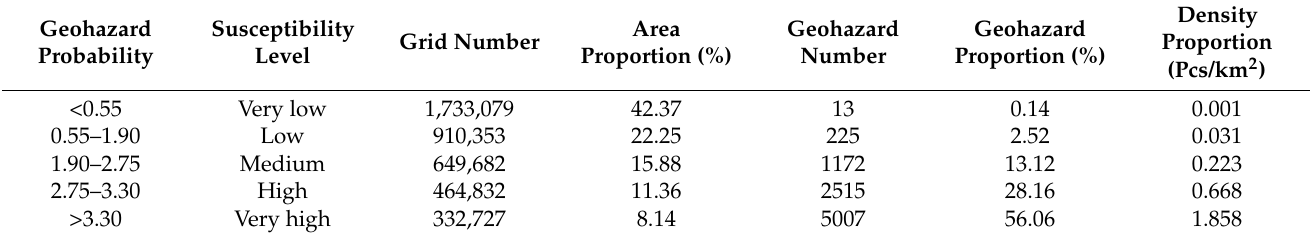
Table 6. Geohazard susceptibility number and proportion for different classes of